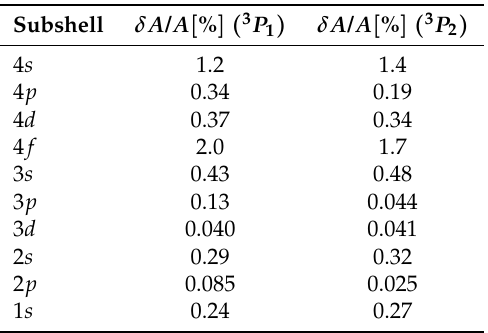
Table 2. Relative change from the preceding calculation in the value of the hyperfine structure constant as the core subshells were opened for single, vv and cv substitutions.